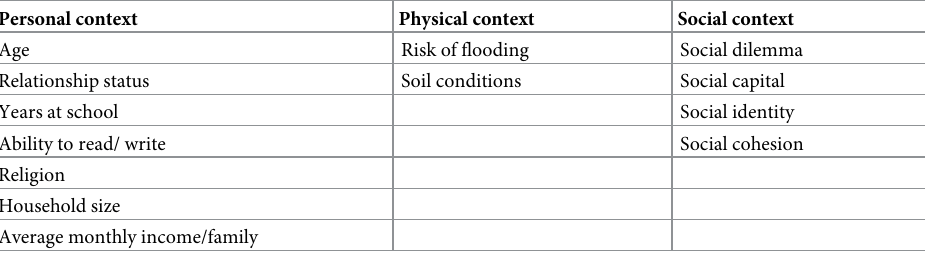
Table 2. Personal, physical and social context